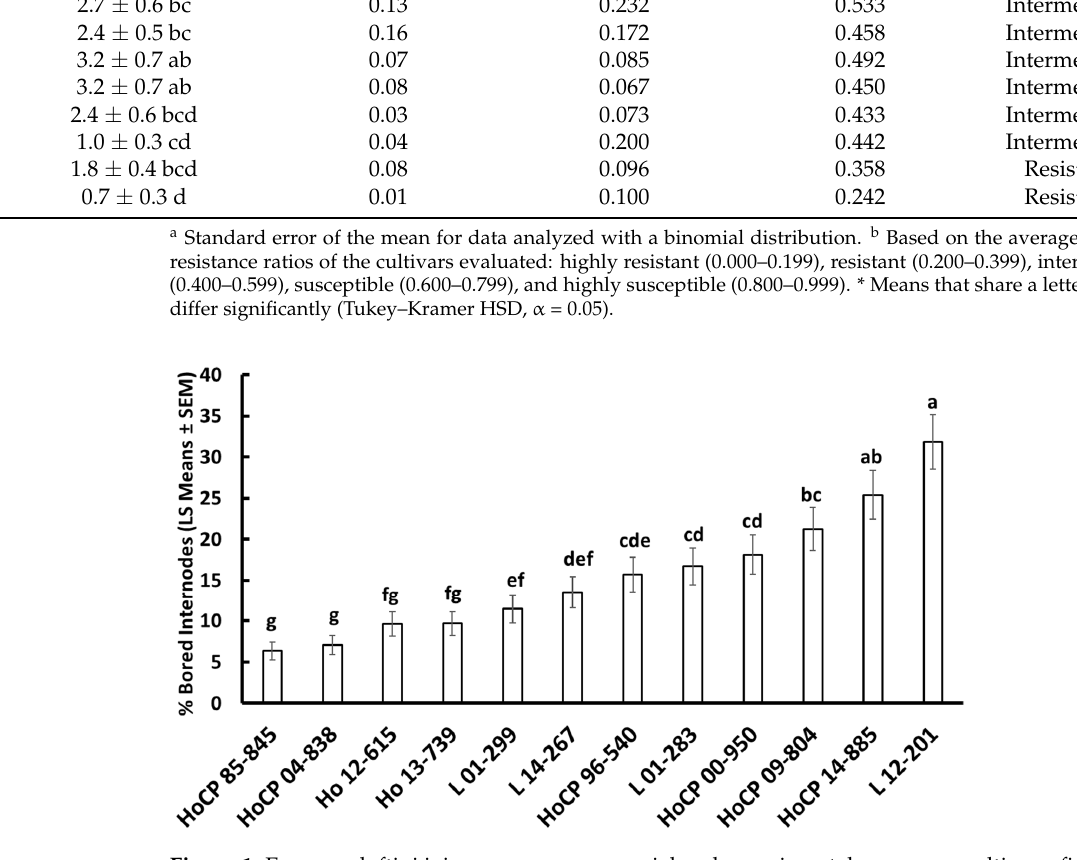
Figure 1. Eoreuma loftini injury among commercial and experimental sugarcane cultivars, field trial, Beaumont, Texas, 2020. Bars that share a letter are not significantly different (Tukey–Kramer HSD, α = 0.05). Standard error of means analyzed with a binomial distribution are reported.